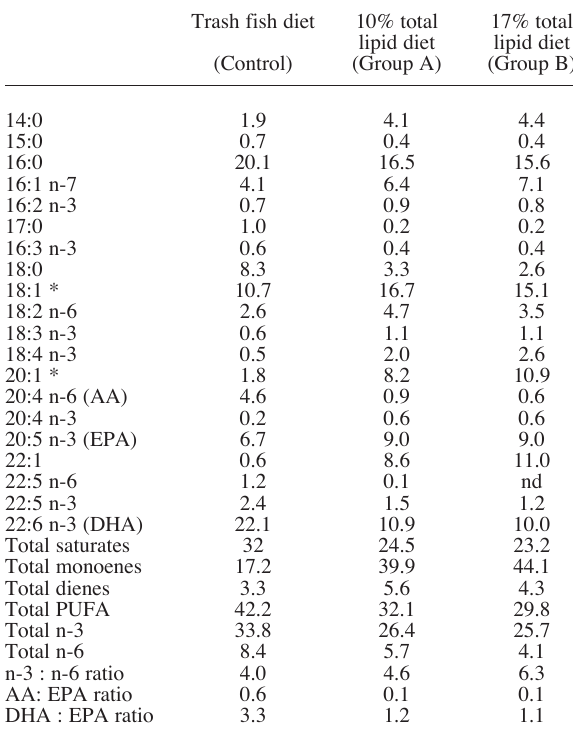
T ABLE 3. – Fatty acid composition of the natural diet (trash fish) used to fed the control group, and the pelleted diets used for the experimental groups: A (10% lipid) and B (17%